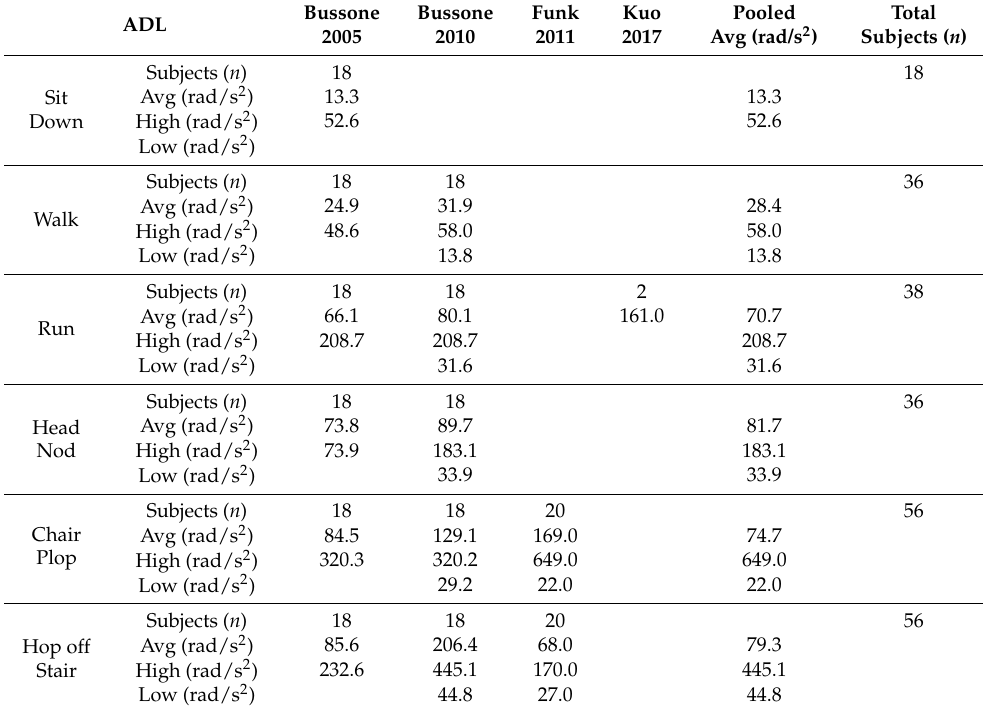
Table 3. Activities of Daily Living, angular head acceleration (rad/s 2